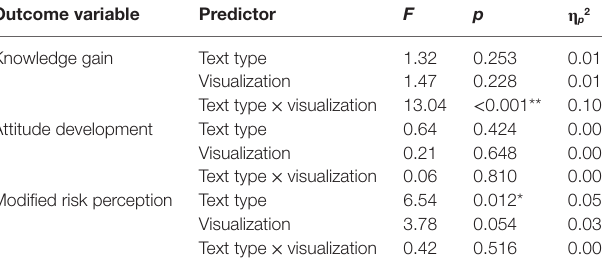
TaBle 2 | ANOVA results (between conditions) for knowledge gain, attitude development, and modified risk perception. Outcome variable